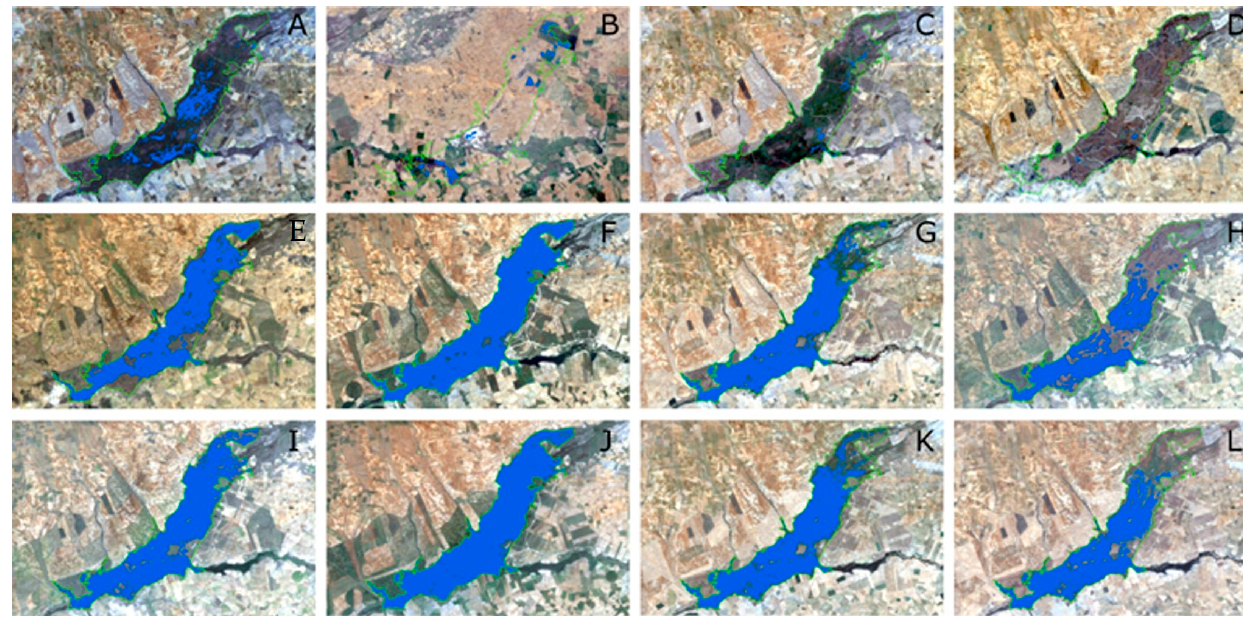
Figure 7. Water bodies in the Tablas de Daimiel National Park delimited according to the MNDWI spectral index. Landsat-5 TM images (threshold − 0.15): ( A ) September 2008, ( B ) April 2009, ( C ) July 2009, ( D ) November 2009, ( E ) January 2010, ( F ) May 2010, ( G ) July 2010, ( H ) December 2010, ( I ) February 2011, ( J ) April 2011, ( K ) July 2011, and ( L ) October 2011.